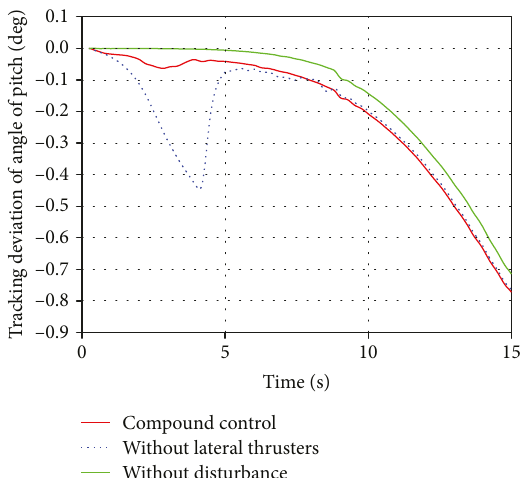
Figure 2: Tracking deviation of angle of pitch in the initial stage of launch.